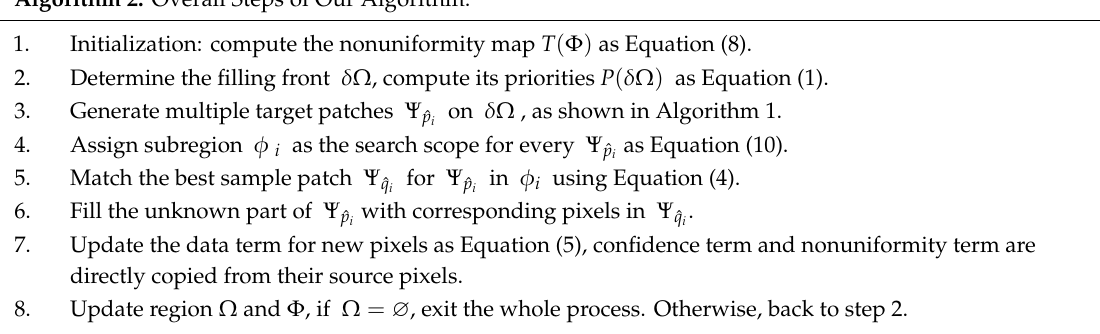
Algorithm 2. Overall Steps of Our